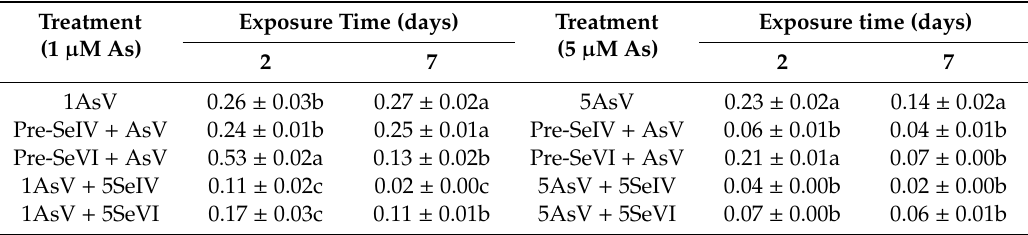
Table 3. E ff ect of Se pretreatment or co-application on the transfer factor of As in seedlings of rice treated with